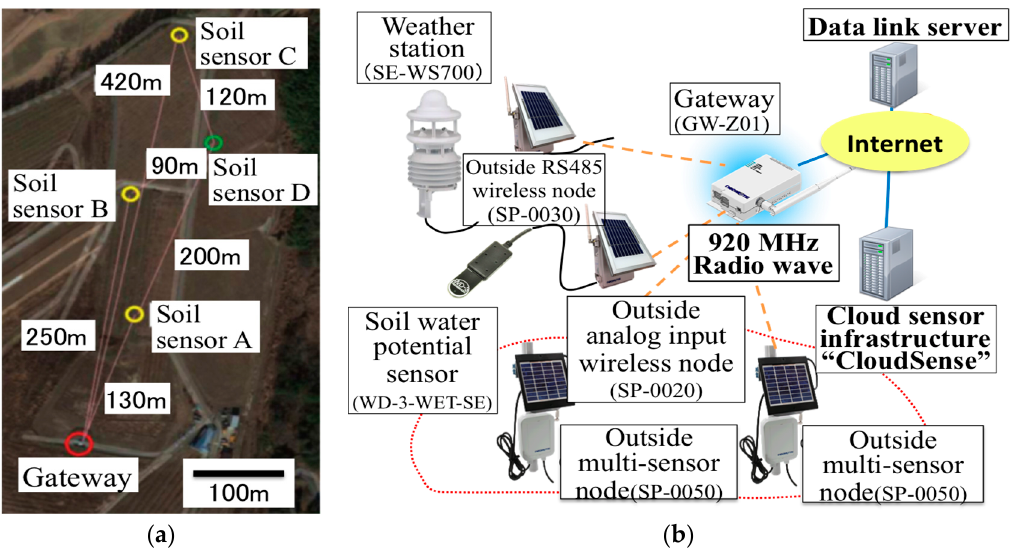
Figure 7. Structure of the WSN in Tomi-no-oka vineyard: ( a ) Installation points of sensors; ( b ) System configuration of WSN.